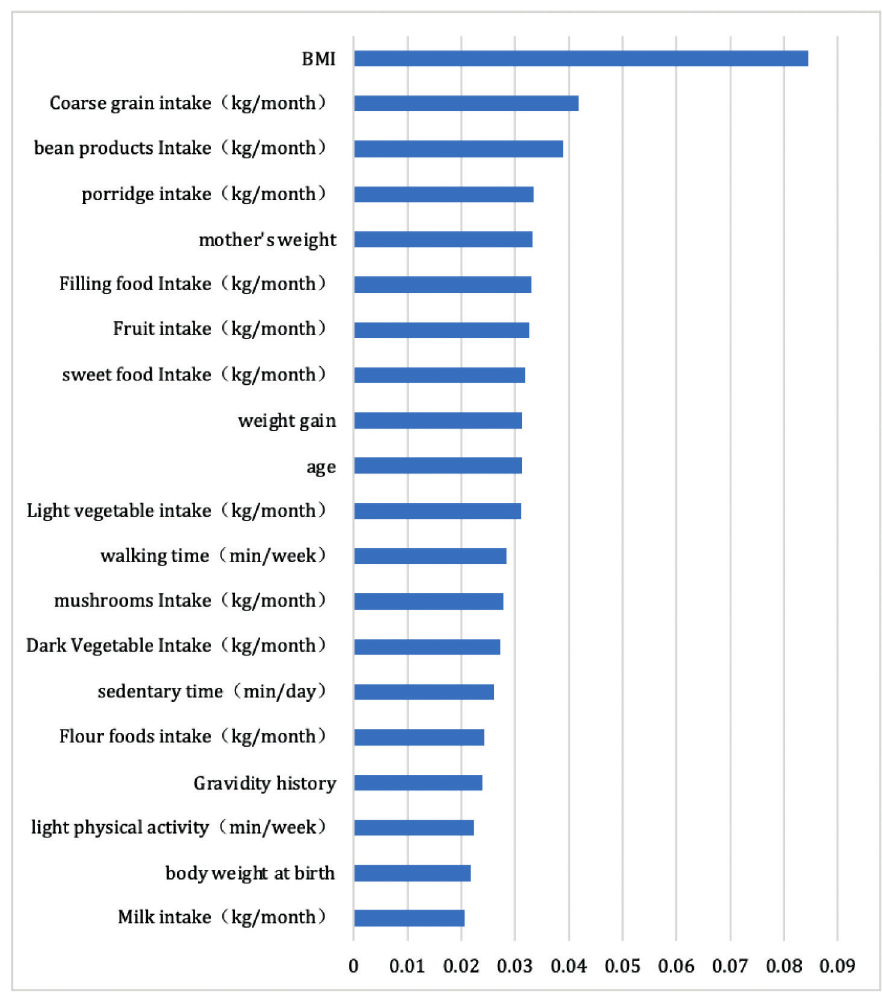
Figure 5. Weighted ranking in the F1 model